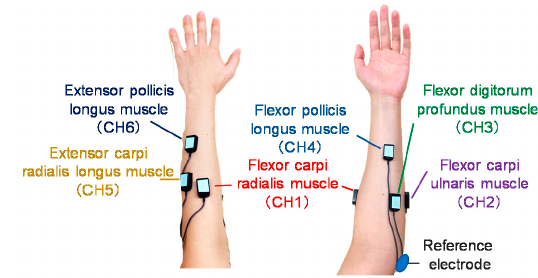
Figure 4. Electrode positions. The positions of the six electrodes are selected with reference to previous work [35]. Table 1. Muscle of the forearm and their functions.